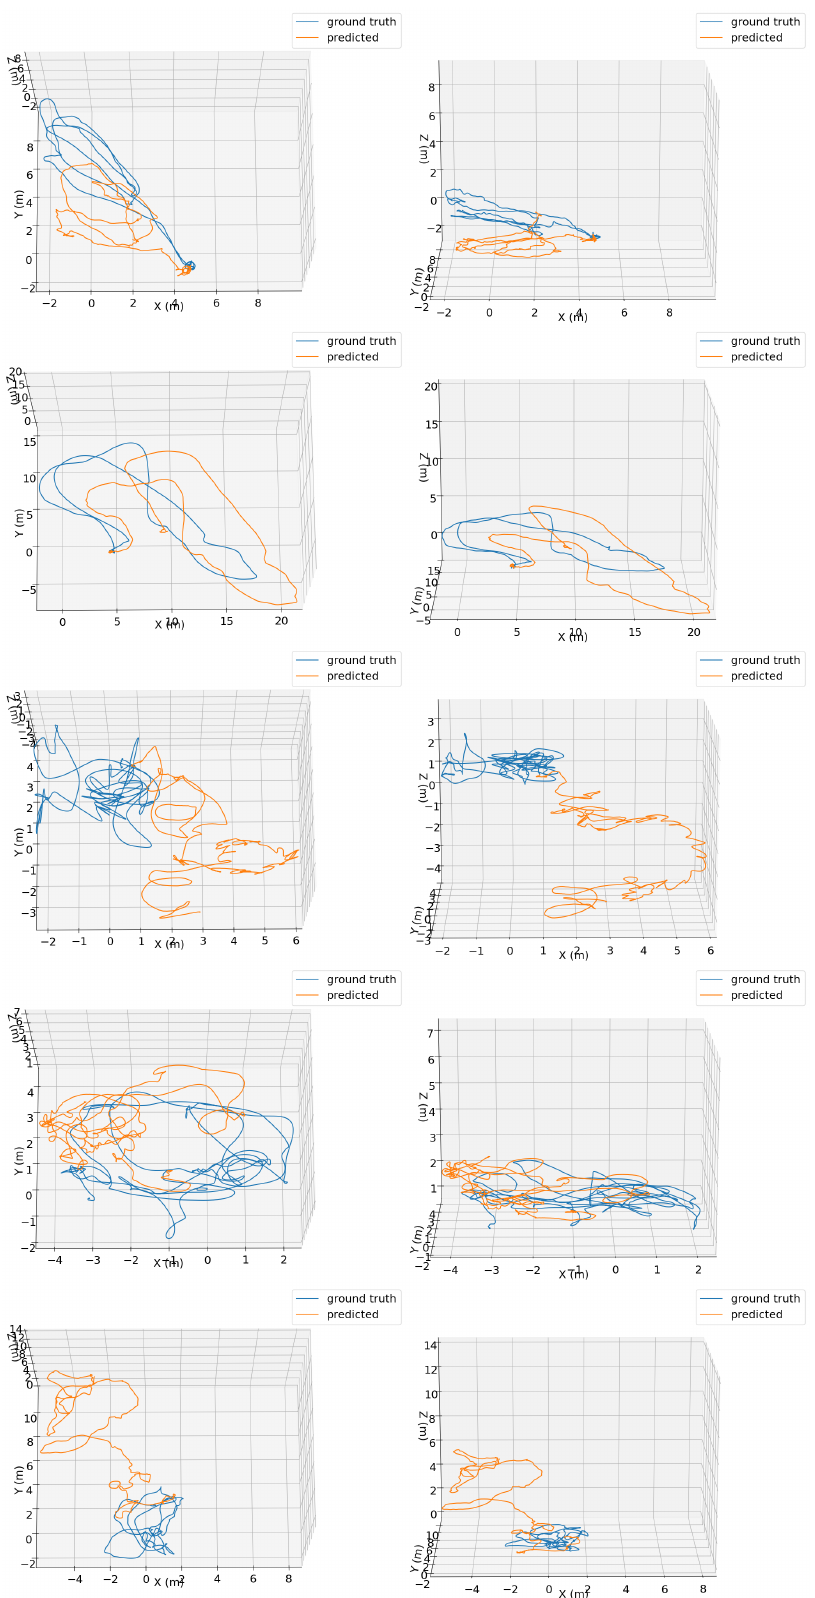
Figure 7. Top ( left column ) and side ( right column ) views of ground truth (blue) and predicted (orange) trajectories using the TMAE+QME configuration for different test sequences of the EuRoC MAV dataset: MH_02_easy ( first row ), MH_04_difficult ( second row ), V1_03_difficult ( third row ), V2_02_medium ( fourth row ) and V1_01_easy ( fifth row